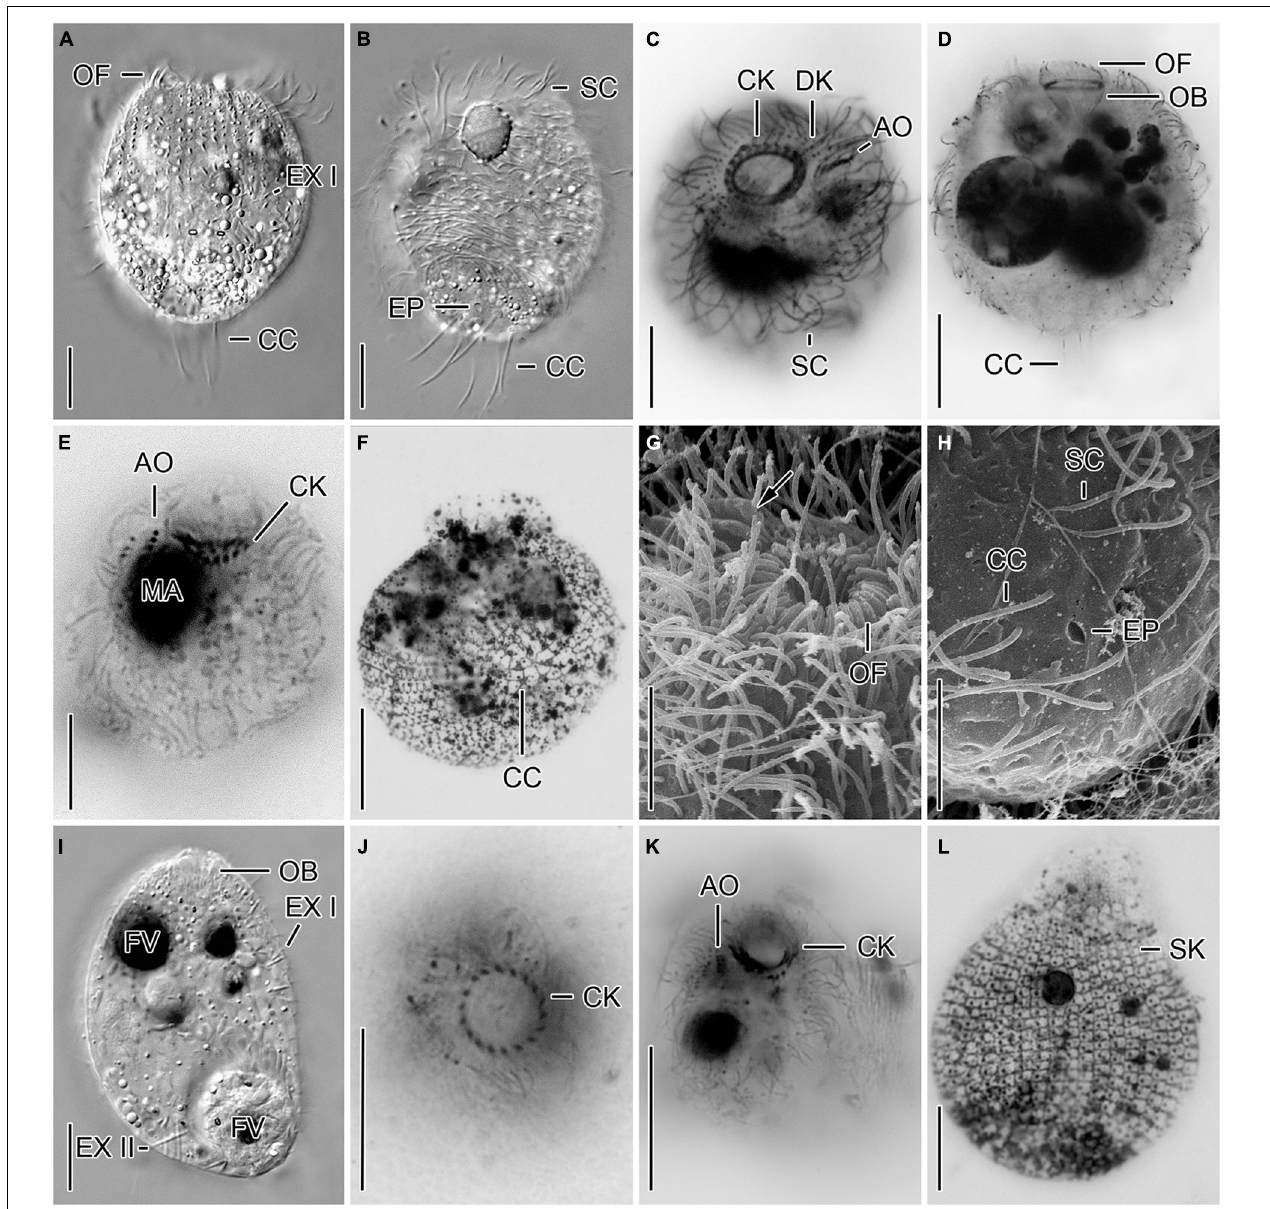
FIGURE 5 | Cryptic species tentatively identified as Urotricha castalia . One species (A–H) is represented by specimens of strains CIL-2019/2 (A,B) , CIL-2019/1 (C,D,F–H) , and of the non-clonal original culture (E) from Lake Zurich, the other species (I–L) by specimens of strains CIL-2017/27 (I) and CIL-2017/25 (J–L) from Lake Mondsee in vivo (A,B,I) , after protargol staining (C–E,J,K) , after dry silver nitrate staining (F,L) , and in the scanning electron microscope (G,H) . (A,E,L) Lateral views. Occasionally, only the ciliated basal bodies of the adoral organelles stain (E) . The silverline pattern is typical (L) . (B) Ventral view. The excretory pore is within the circle of caudal cilia. (C,G,K) Oblique top views. Arrow denotes distinct ridges between adoral organelles. (D,I) Longitudinal optical sections. (F,H) Oblique posterior polar views. The silverline pattern is composed of polygonal meshes in the unciliated cell portion and the caudal cilia insert in rather circular meshes (F) . The excretory pore is within the circle of caudal cilia (H) . (J) Top view. AO, adoral organelles; CC, caudal cilia; CK, circumoral kinety; DK, dikinetids at anterior end of somatic kineties; EP, excretory pore; EX I, small extrusomes in ciliated anterior cell portion; EX II, large extrusomes in unciliated posterior cell portion; FV,